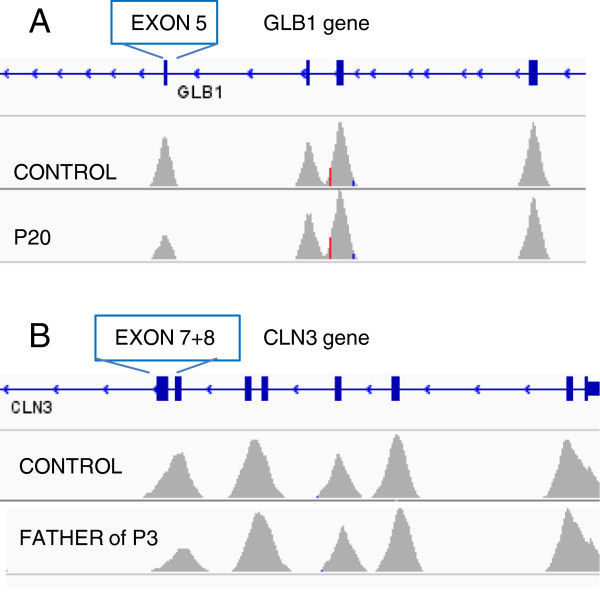
Heterozygous macrodeletions detected by LSD-NGS. A) GLB1 exon 5 deletion; B) CLN3 exon 7 + 8 deletion. The area of the coverage peak for each deleted exon is half that seen in the corresponding control sample.